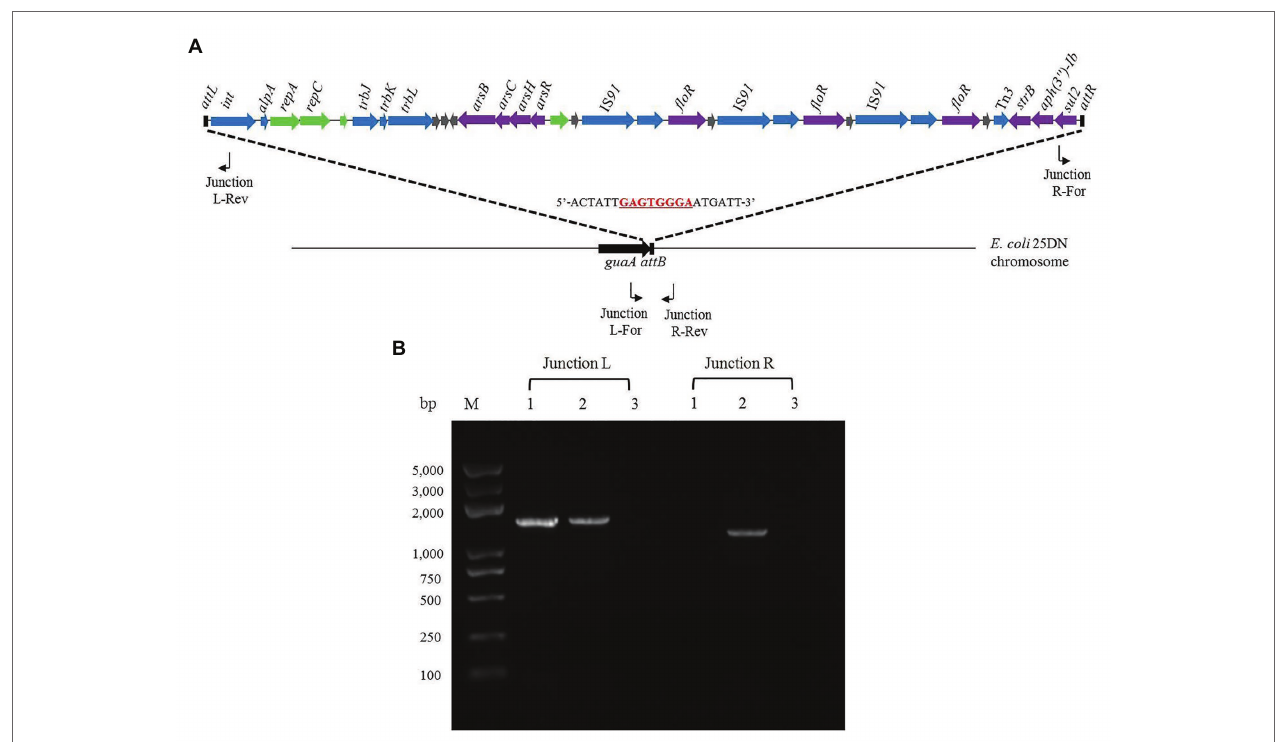
FIGURE 4 | Analysis of the insertion site of ICE Rsp D18B in transconjugant 25D18-B4. (A) PCR primer positions in ICE Rsp D18B and in the strain 25DN chromosome are indicated by bent arrows. The insertion site of ICE Rsp D18B in the strain 25DN chromosome is indicated by dashed lines, and the cutting site (5 ' -GAGTGGGA-3 ' ) of the integrase (Song et al., 2012) is underlined and marked in red. (B) Gel picture of the PCR products generated by the Junction L-For/ Junction L-Rev and Junction R-For/Junction R-Rev primer pairs. Total DNA of strain D18 (lanes 1), transconjugant strain 25D18-B4 (lanes 2), and strain 25DN (lanes 3) was used as template. M, molecular size markers.